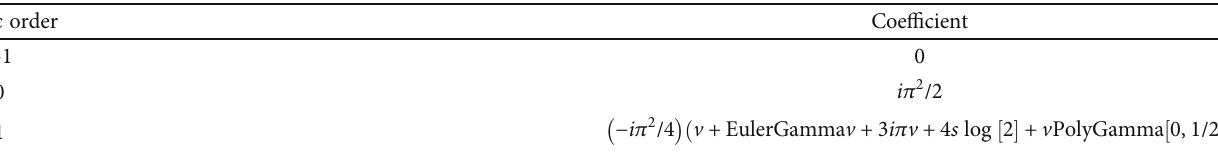
Table 4: A 4 ε series ½ 1, 1 (cid:3)